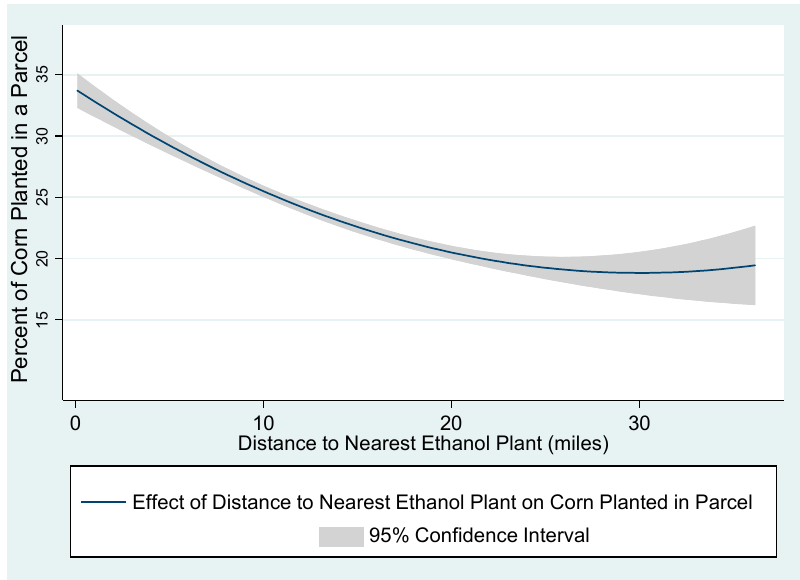
Figure 3. Distance to nearest ethanol plant and percent of corn planted in a parcel.